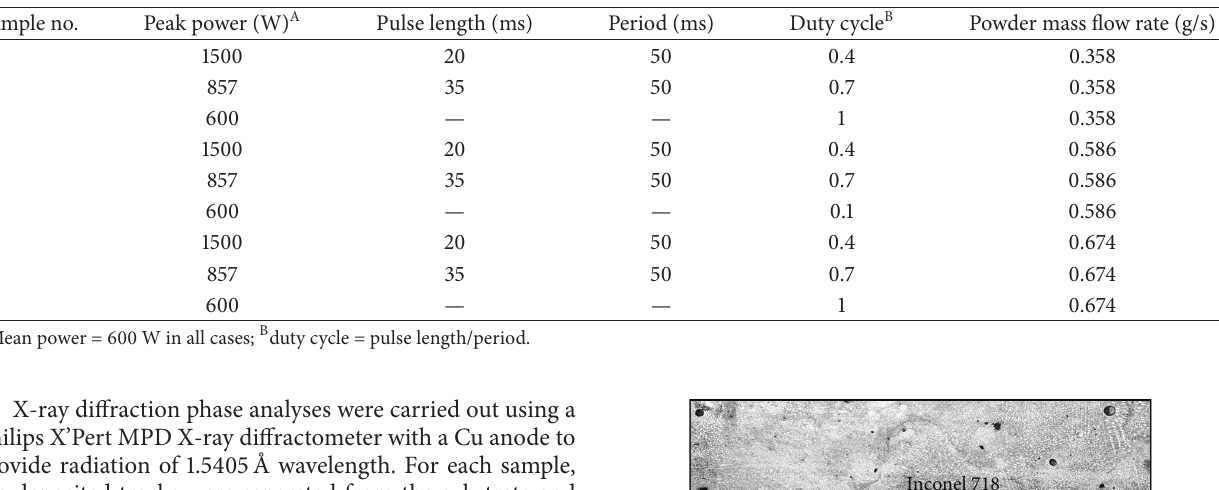
Table 1: Experimental parameters used in the experiment.